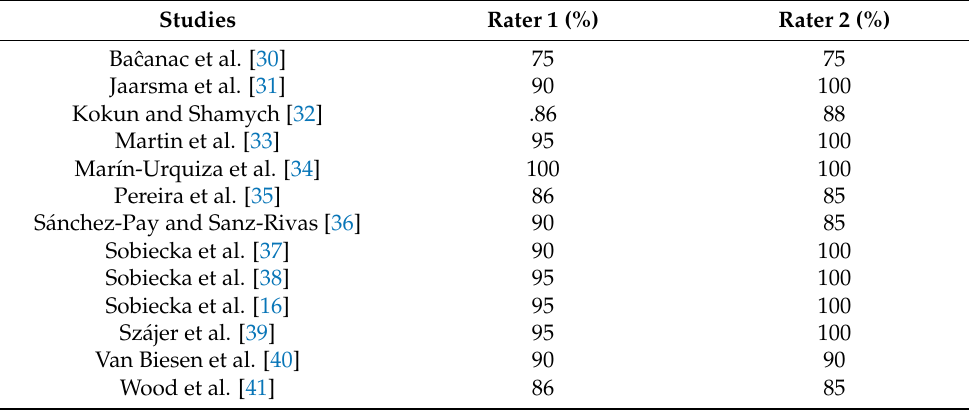
Table 1. Quality assessment of qualitative studies. Table 2. Quality assessment of quantitative